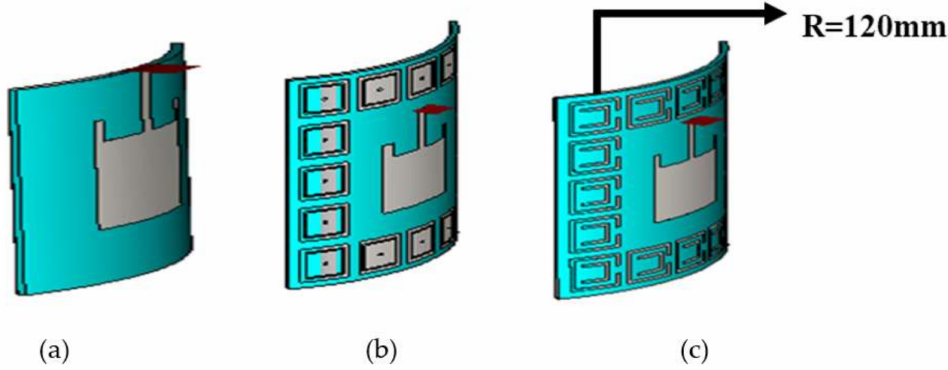
Figure 10. Geometric model of dual-band antennas in free space. ( a ) Conventional antenna. ( b ) EBG- based antenna. ( c ) SRR-based